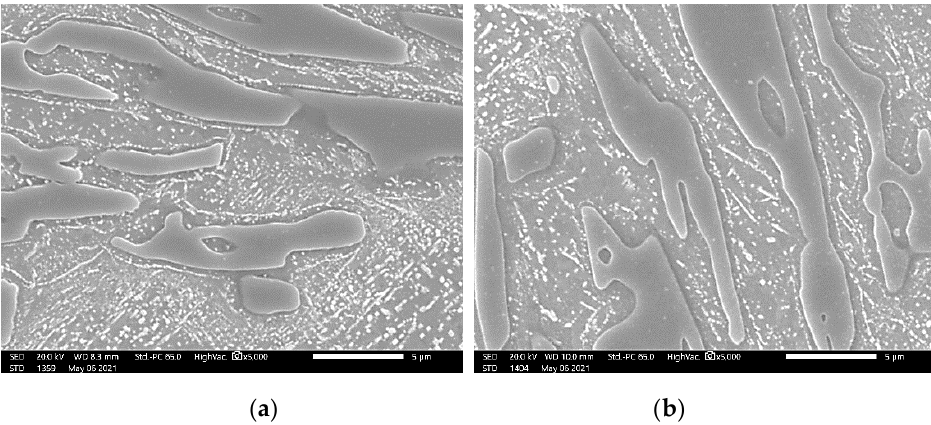
Figure 11. Micrographs of DA ( a ) 2127 and ( b ) 2427 showing M 7 C 3 interface morphology and PFZ gap among M 7 C 3 and M 23 C 6 particles.